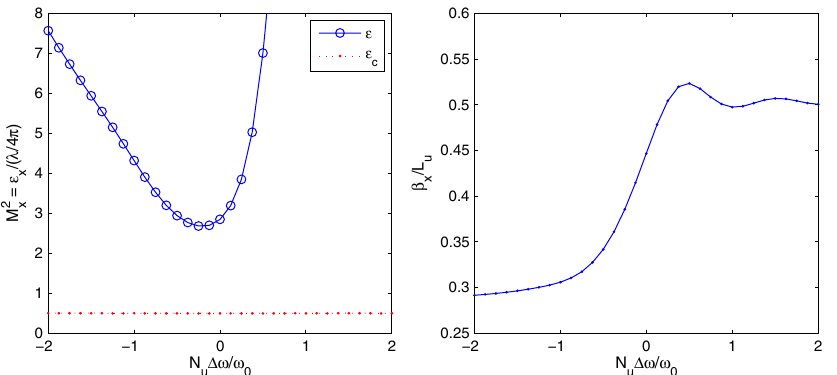
FIG. 17. Light 100% and core emittances (left) and beta function (right) at the undulator center corresponding to Fig. 15 for different detuning off the resonance.